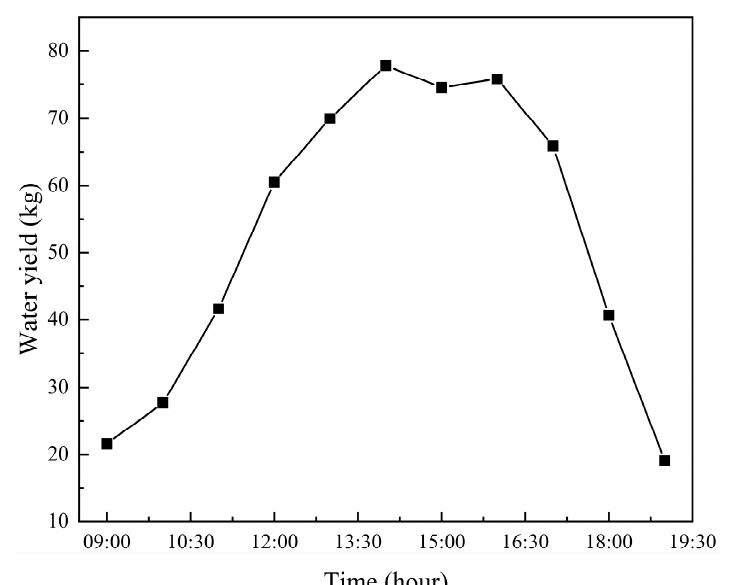
Figure 5. The freshwater yield over time.